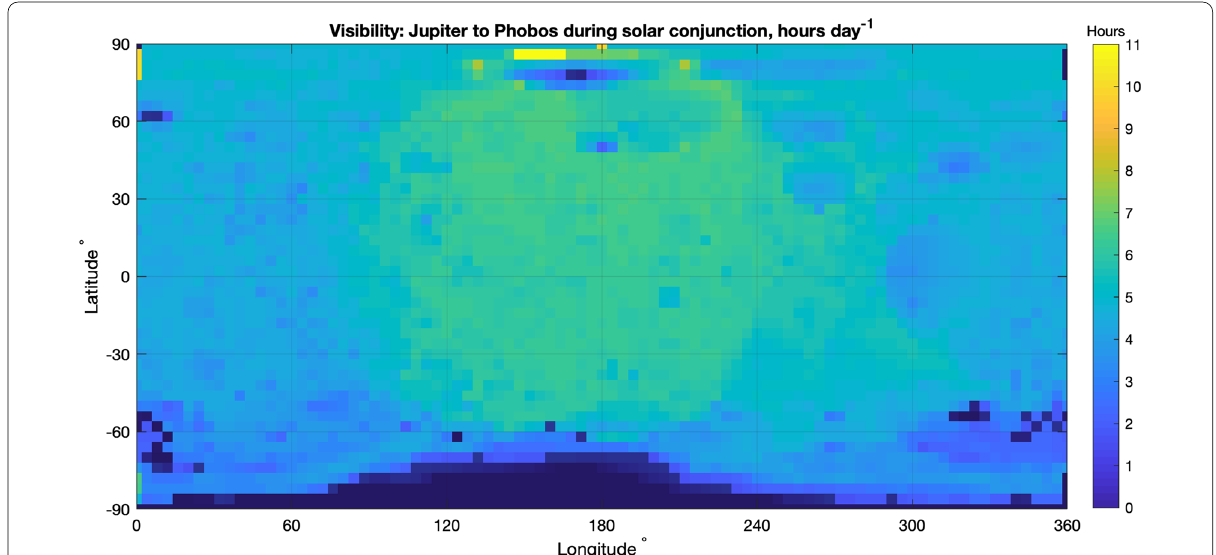
Fig. 9 Map of Phobos. Mean Jupiter to Phobos visibility hours per day averaged over the period of the solar conjunction between Jupiter and Earth (26 Nov 2030 – 4 Dec 2030). The shaded area (dark blue) represents locations where any single day in that period contains less than 3 hours visibility between Jupiter and